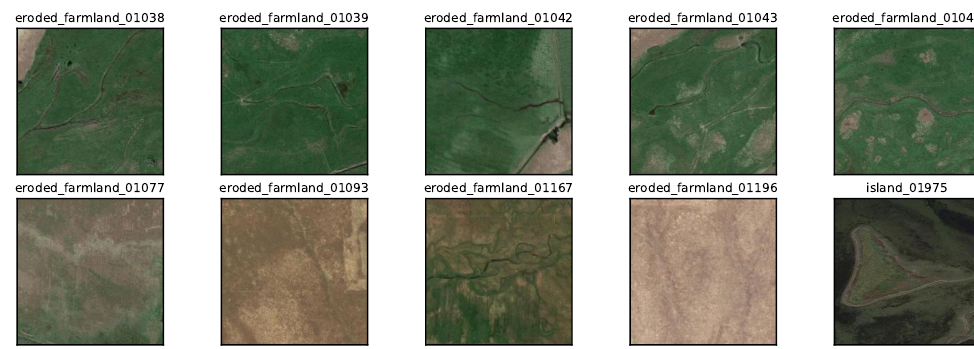
Figure 2. Images from the MLRSNet dataset that do not have labels